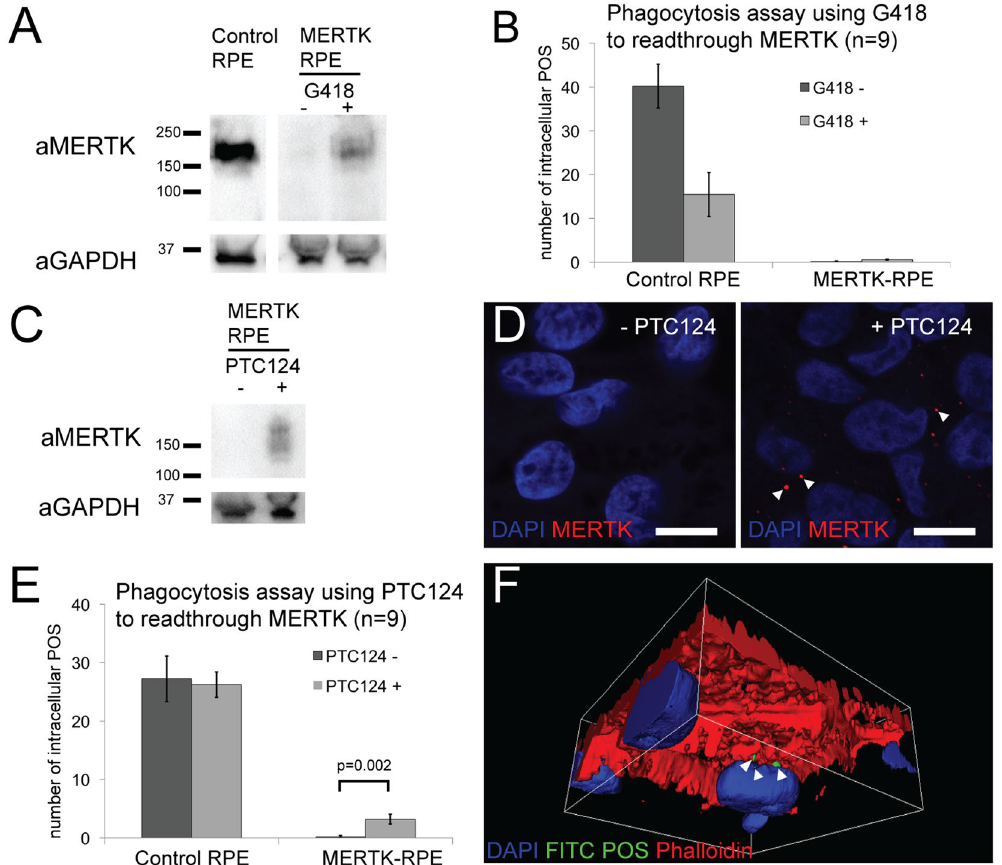
Figure 4. Translational readthrough inducing drugs are able to restore expression of MERTK in the MERTK- RPE and have an effect on phagocytosis. ( A) Cropped Western blot of the MERTK protein in control RPE and MERTK-RPE treated with G418. ( B ) Outcome of phagocytosis assay with and without G418 in control RPE and MERTK-RPE. ( C ) Cropped Western blot of MERTK protein in control and MERTK-RPE treated with PTC124. ( D ) Immunocytochemistry of MERTK protein in MERTK-RPE treated with PTC124, arrows highlight MERTK expression (scale bar 10 μ m). ( E ) Outcome of phagocytosis assay with and without PTC124 in control and MERTK-RPE. ( F ) 3D model derived from confocal stack, viewed from below, showing MERTK-RPE treated with PTC124, 6 hours after the addition of PTC124; arrows show internalised POS (error bars represent the mean ± 1SEM and p values derived from students